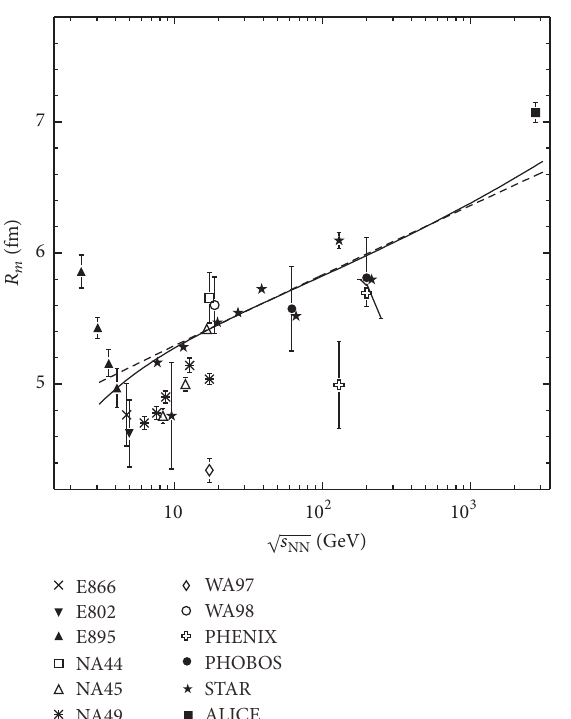
Figure 3: Energy dependence of 𝑅 𝑚 for secondary charged pions in central heavy ion collisions Au + Au, Au + Pb, and Pb + Pb in midrapidity region and at ⟨𝑘 ⊥ ⟩ ≃ 0.2 GeV/ 𝑐 . Error bars are only statistical (for NA44, total uncertainties). Smooth curves are derived from (4) and the fit results for BEC radii [15] without the point of the WA97 experiment [16]. The solid line corresponds to the fits of BEC radii by function (7) and dashed line to the fits by specific case ∝ ln 𝜀 . ∀𝑖 = 𝑠,𝑜, 𝑙 : 𝑅 𝑖